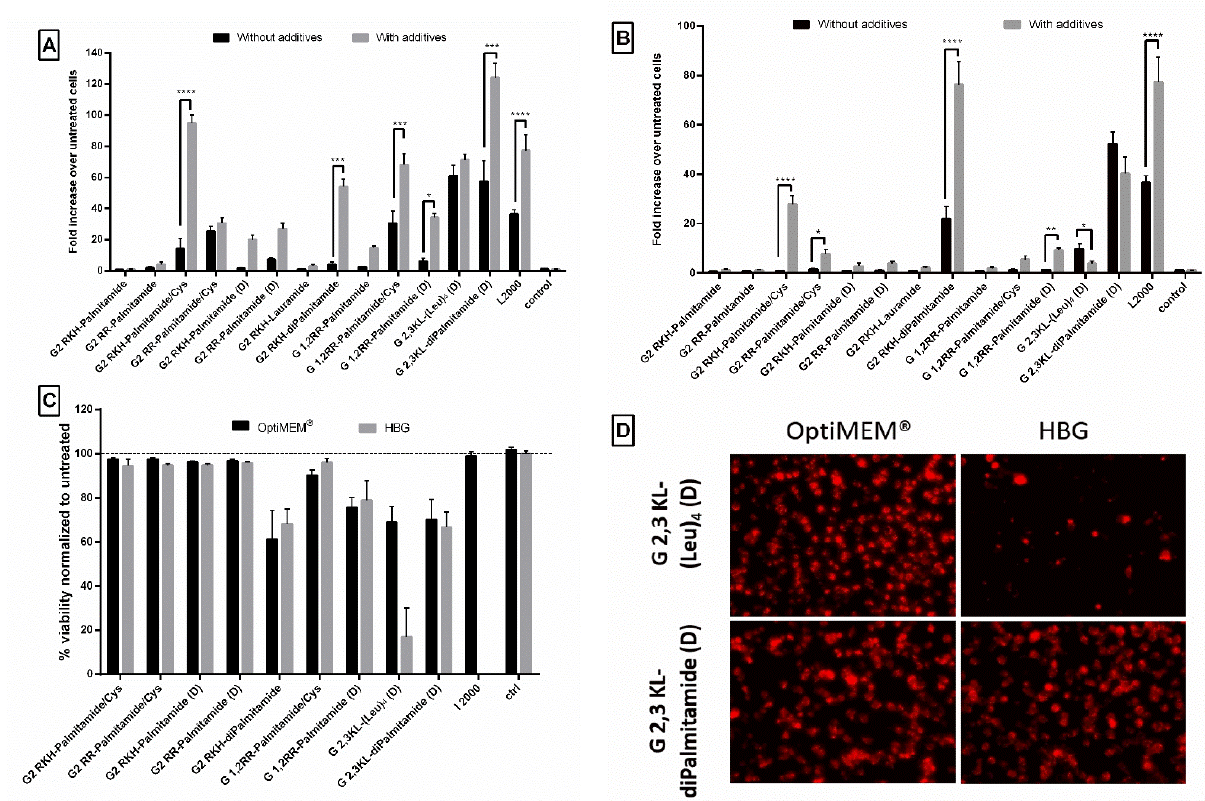
Figure 8. The effect of the polymeric excipient, PVA 18, on transfection efficiency and cell viability after transfection of HeLa Luc/705 cells with the lipophilic peptide dendrimer/ON complexes in serum-containing media. Fold increase in the luciferase activity (RLU normalized by the total amount of protein and related to values for untreated cells). ( A ) dendrimers were formulated in OptiMEM ® , ( B ) dendrimers were formulated in HBG. ON complexed with L2000 was used as positive control and ON alone as negative control. ON concentration: 100 nM. ( C ) Viability of HeLa Luc/705 cells after transfection in serum-containing media with dendrimer/ON complexes with PVA18 excipient. Results were normalized to the viability of untreated cells. ( D ) Cellular uptake behavior after HeLa Luc/705 reporter cells transfection in serum-containing media of the 3rd generation peptide dendrimer/Alexa-568-labelled ON/PVA18 complexes formulated in different media. Complexes were incubated for 24 h, at 37 °C in a humidified incubator with 5% CO 2 . Live cells were rinsed with DMEM ® with no phenol red (Invitrogen), before imaging with the fluorescence microscope (Olympus IX81). (magnification 20×, Scale bar = 100 µm. Values represent the mean with the SEM of at least three experiments performed in triplicate ( n ≥ 3). p -values calculated by Two-way ANOVA test and statistical difference with and without PVA 18 for each complex in each formulating buffer were compared using post hoc Fisher’s LSD test (ns: non-significant, * p ≤ 0.05, ** p ≤ 0.01, *** p ≤ 0.001 and **** p ≤ 0.0001).